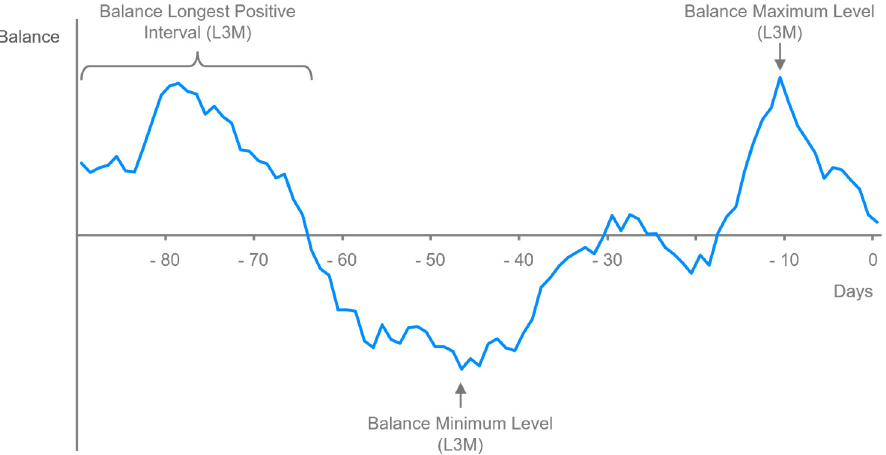
Figure 3. Illustration of three of the new features generated from the balancefile . The last 90 relevant days of accounting information were used for each customer to create aggregated balance features.